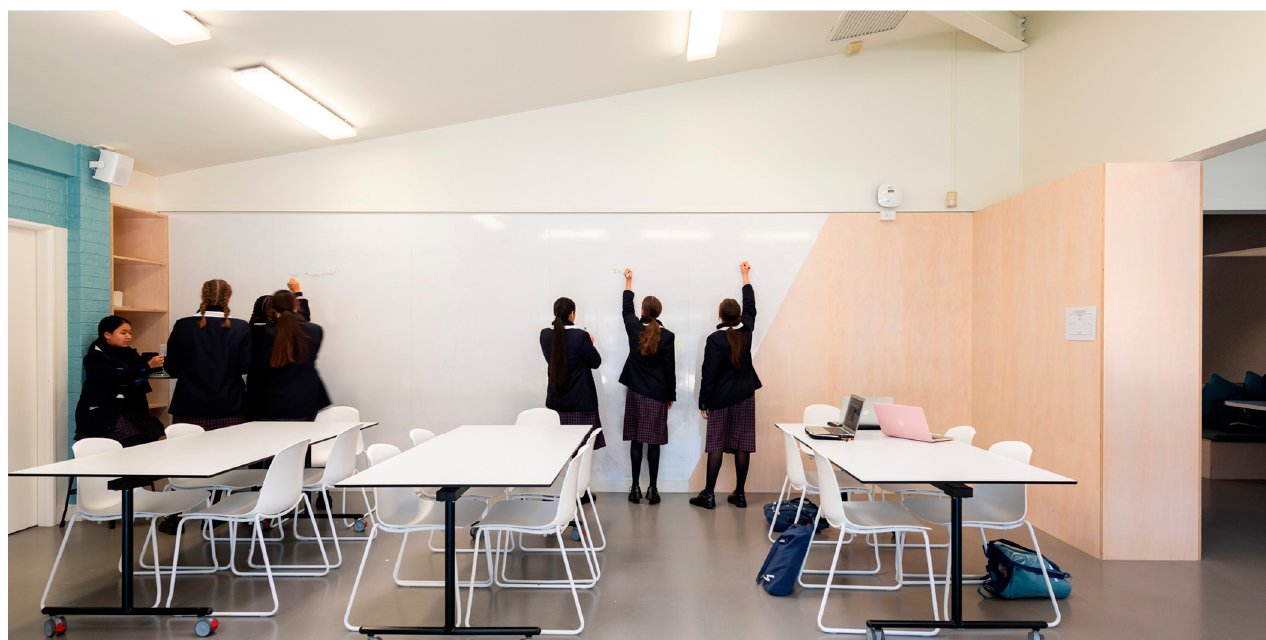
Figure 2. Writeable walls and table-tops enable students to brainstorm and share thinking with each-other (Image courtesy of Hayball architects).